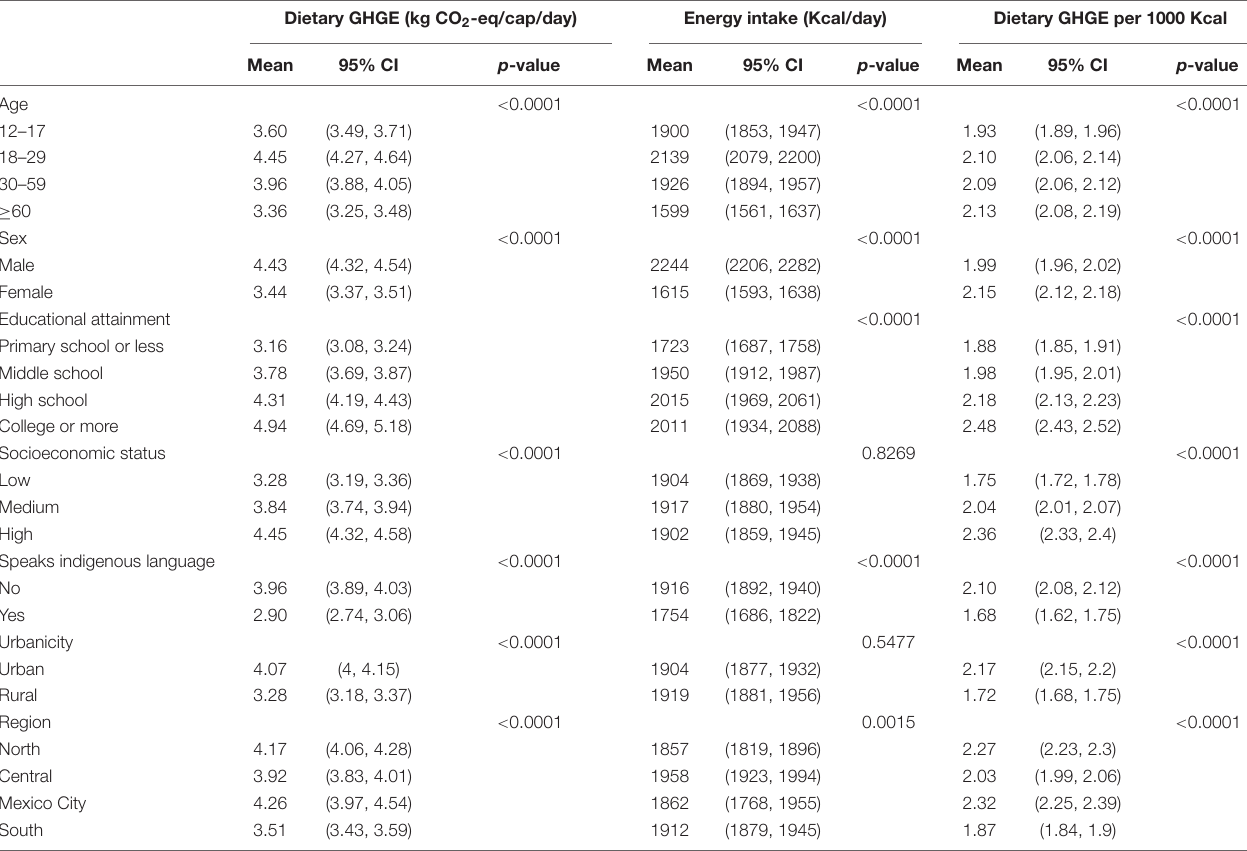
TABLE 2 | Total dietary greenhouse gas emissions and energy intake per day among the Mexican population, by socio-demographic characteristics. Dietary GHGE (kg CO 2 -eq/cap/day) Energy intake (Kcal/day) Dietary GHGE per 1000